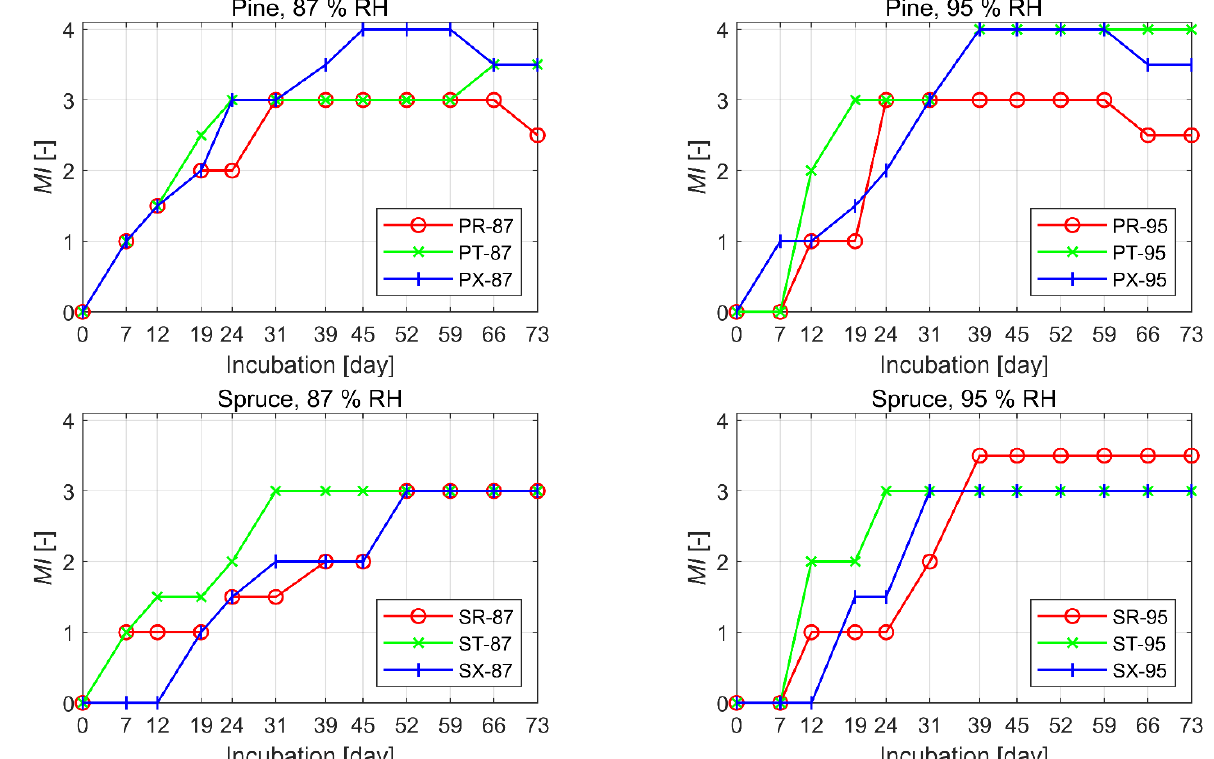
Figure 3. Mold index MI (defined according to Table 2) over time for all wood specimens tested. The mold growth curves are presented as the average for each subset of specimens.